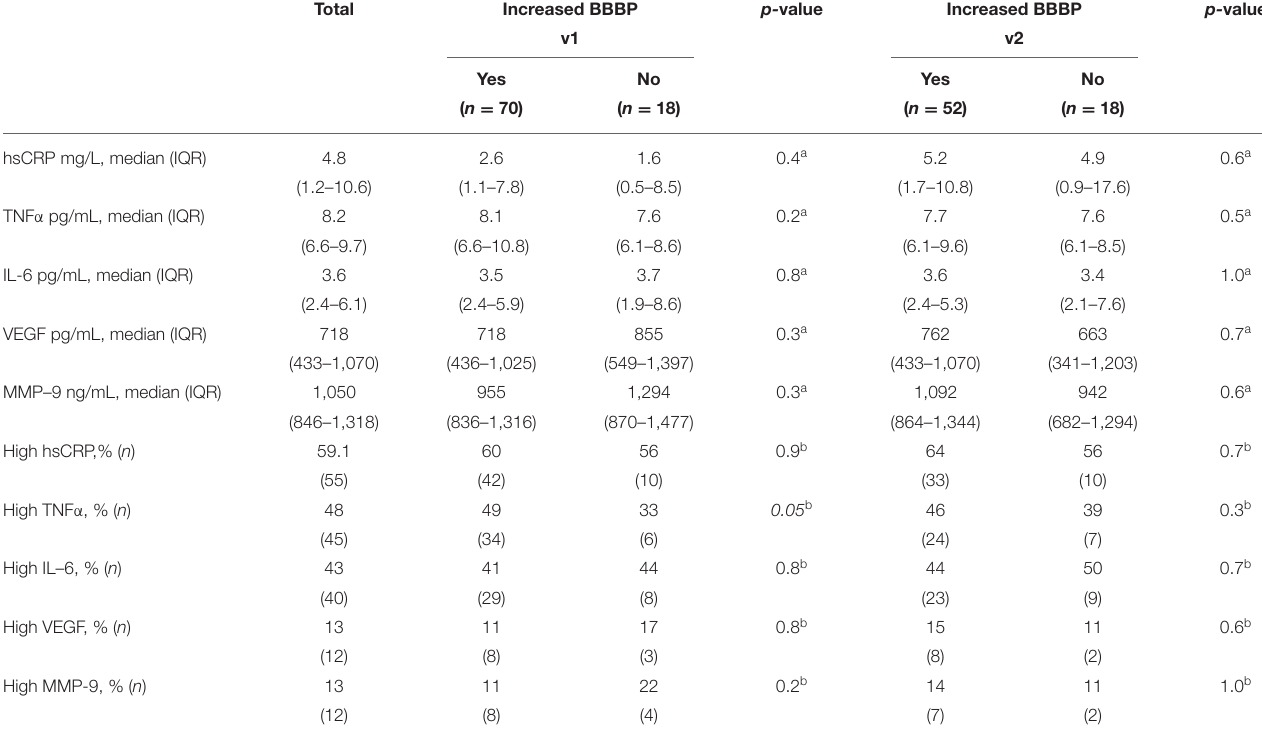
TABLE 6 | Serum biomarkers before (v1) intervention in patients with or without increased BBBP before and after (v2) intervention.